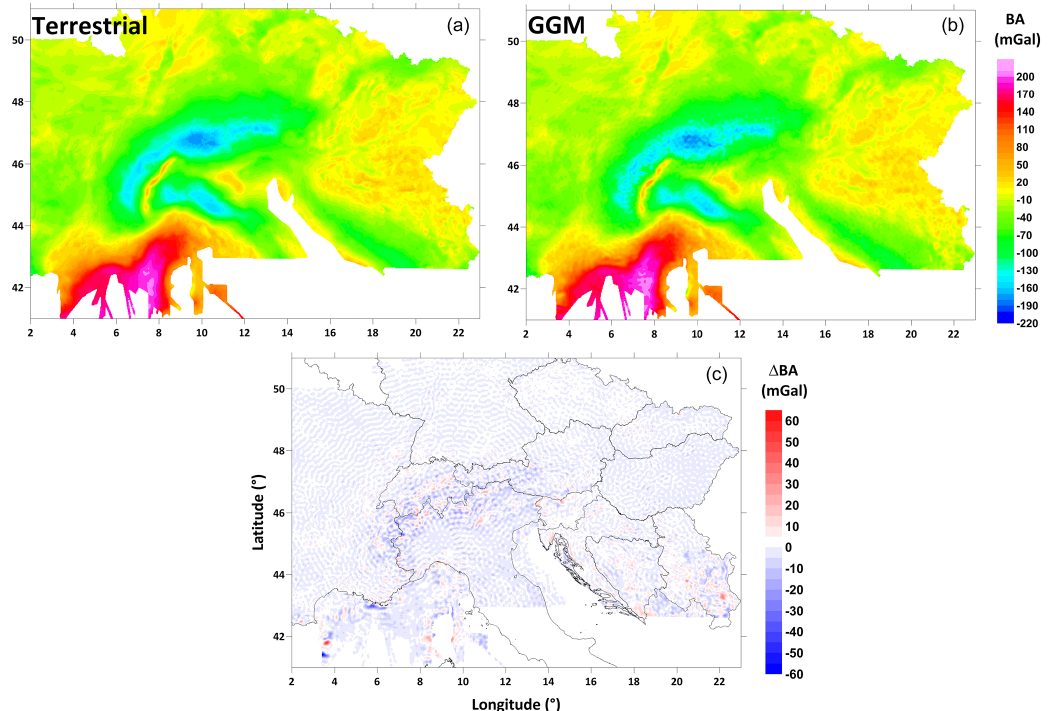
Figure 12. Comparison of Bouguer anomaly maps (correction density 2670kgm − 3 ) derived from terrestrial data (a) and GGM EIGEN- 6C4 (b) . The bottom map (c) shows the difference between the